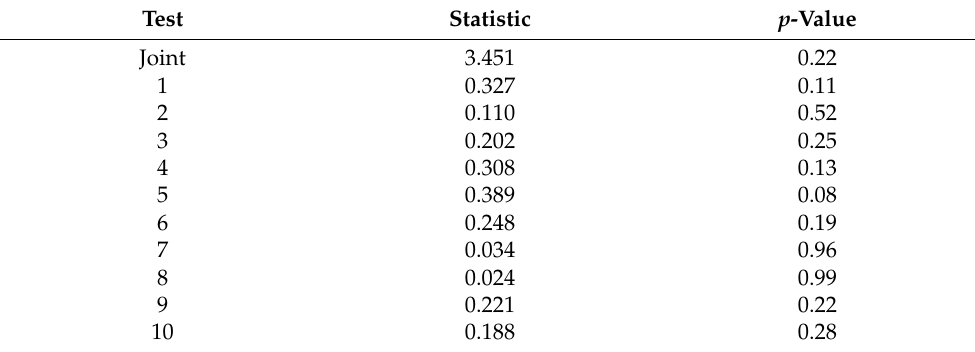
Table 4. Results of the fluctuations